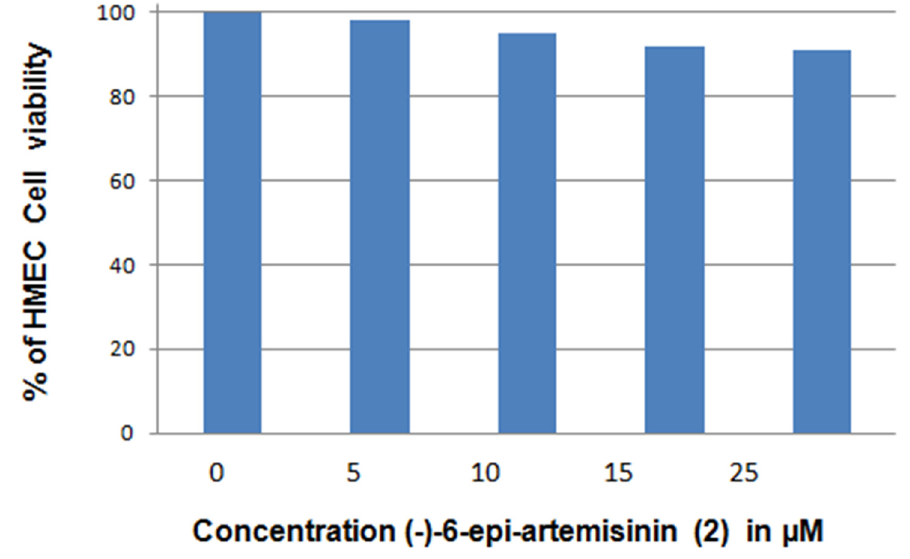
Figure 7. Effect of ( − )-6-epi-artemisinin (2) on cell viability of normal Human Mammary Epithelial Cells